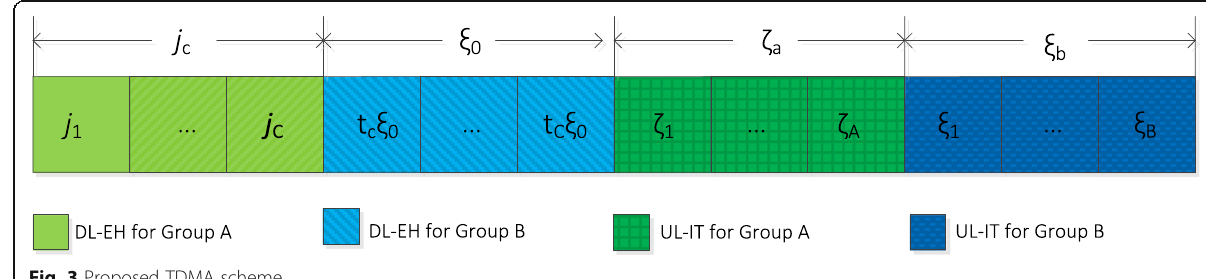
Fig. 3 Proposed TDMA